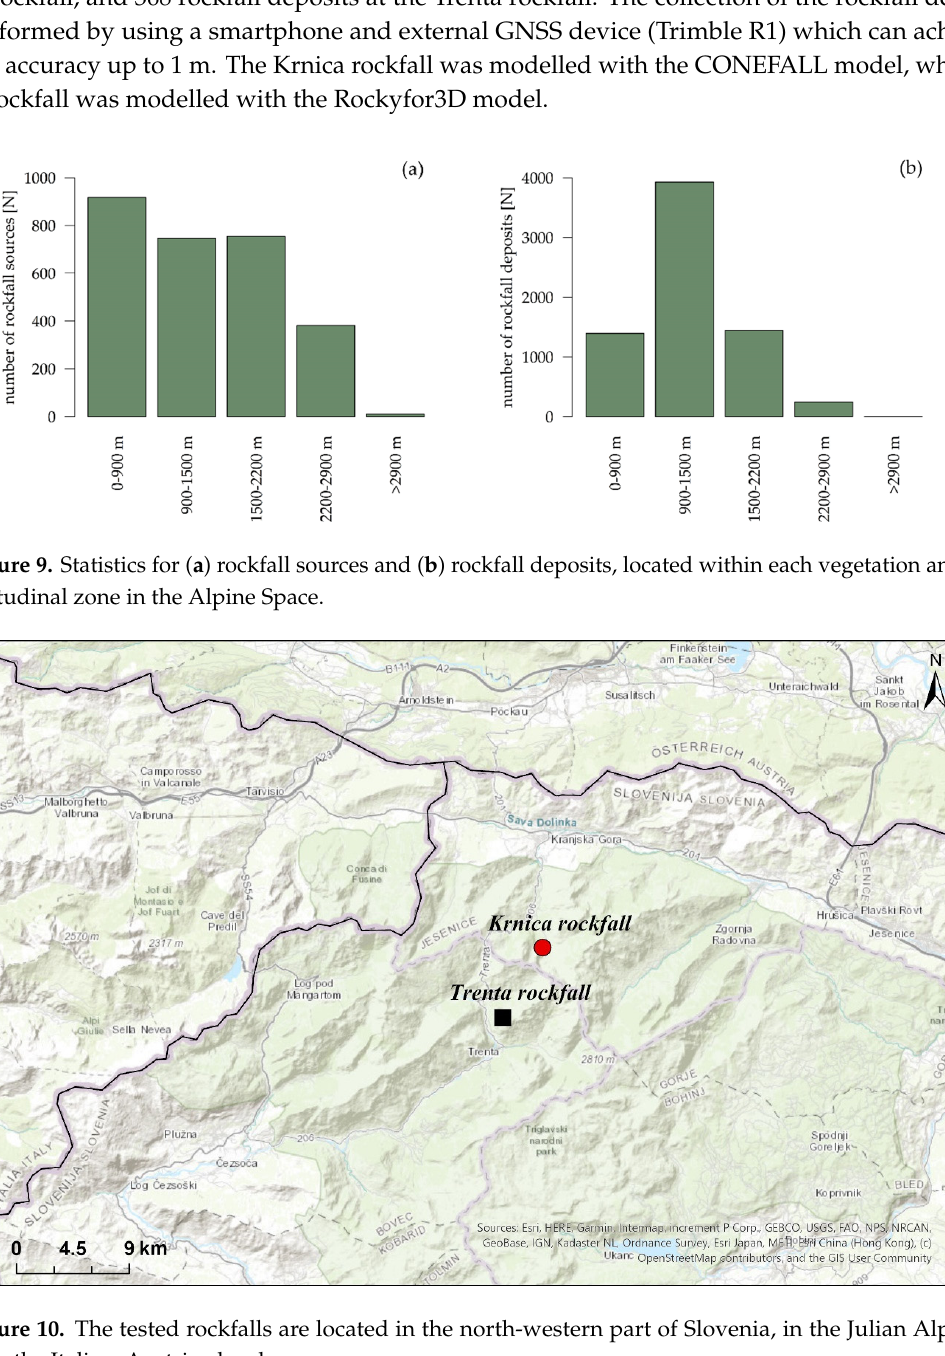
Figure 8. Energy line angles (°) for rockfall deposits in the Alpine Space.